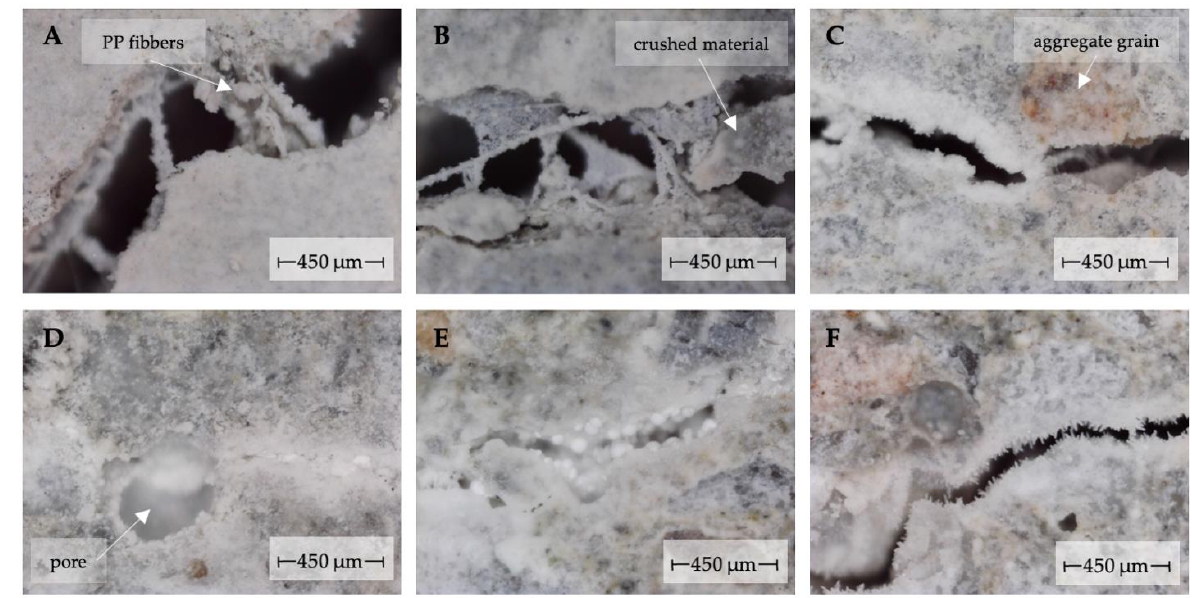
Figure 3. Irregularities in the degree of crack filling by newly formed material in the area of dispersed reinforcement fibers ( A ) or fragments of crushed material ( B ); local irregularities in crack self-sealing in the area of aggregate grains ( C ) and pores ( D ); diversity of morphology of newly formed material in the crack area ( E , F ).